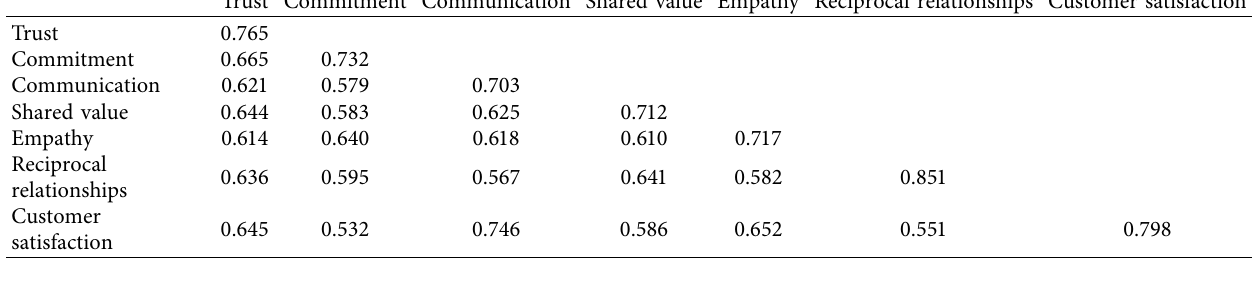
Table 6: Divergent validity of the model.